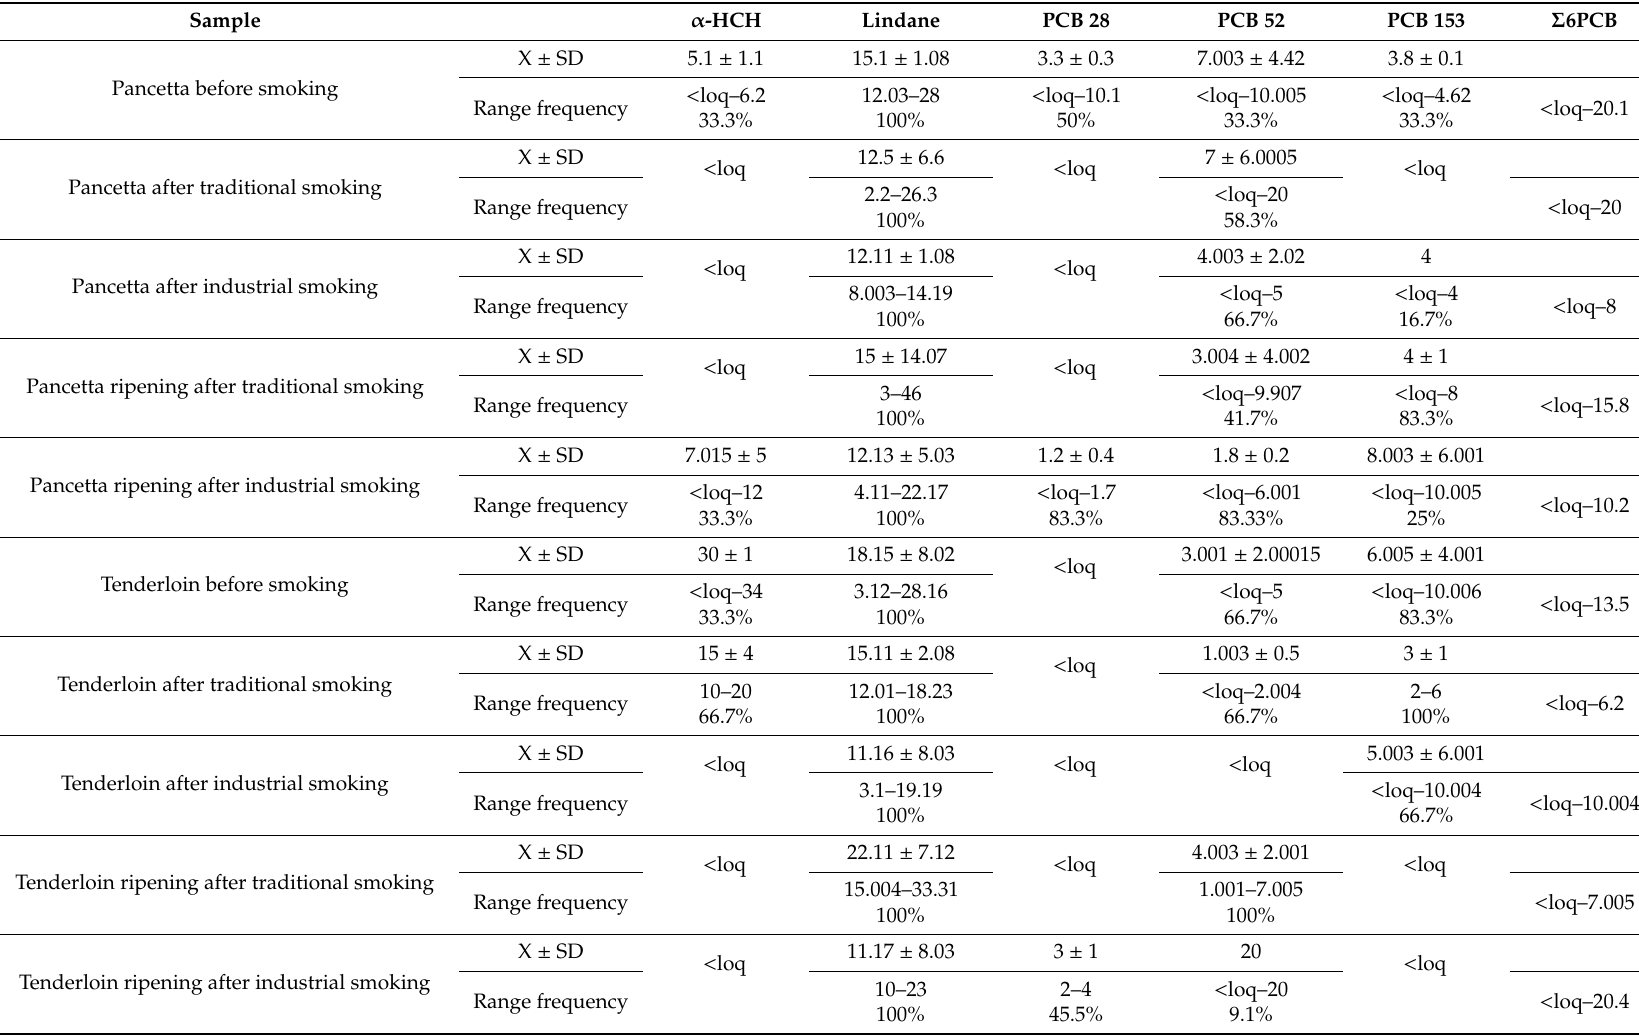
Table 5. Level of OCPs and PCBs (above the LOD and LOQ values) in di ff erent smoked pork meat products ( µ g /